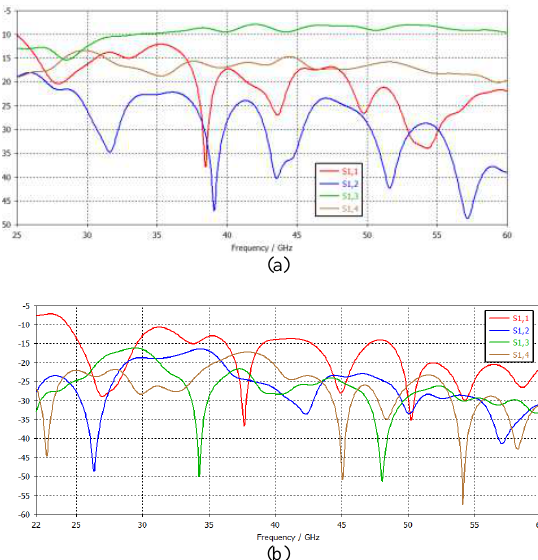
Fig11. Simulated radiation patterns at 38 GHz and 37.4 GHz of the proposed MIMO 2X2 antenna, (a) 3D, (b) polar radiation, (c) 3D, (d) polar radiation of first and second